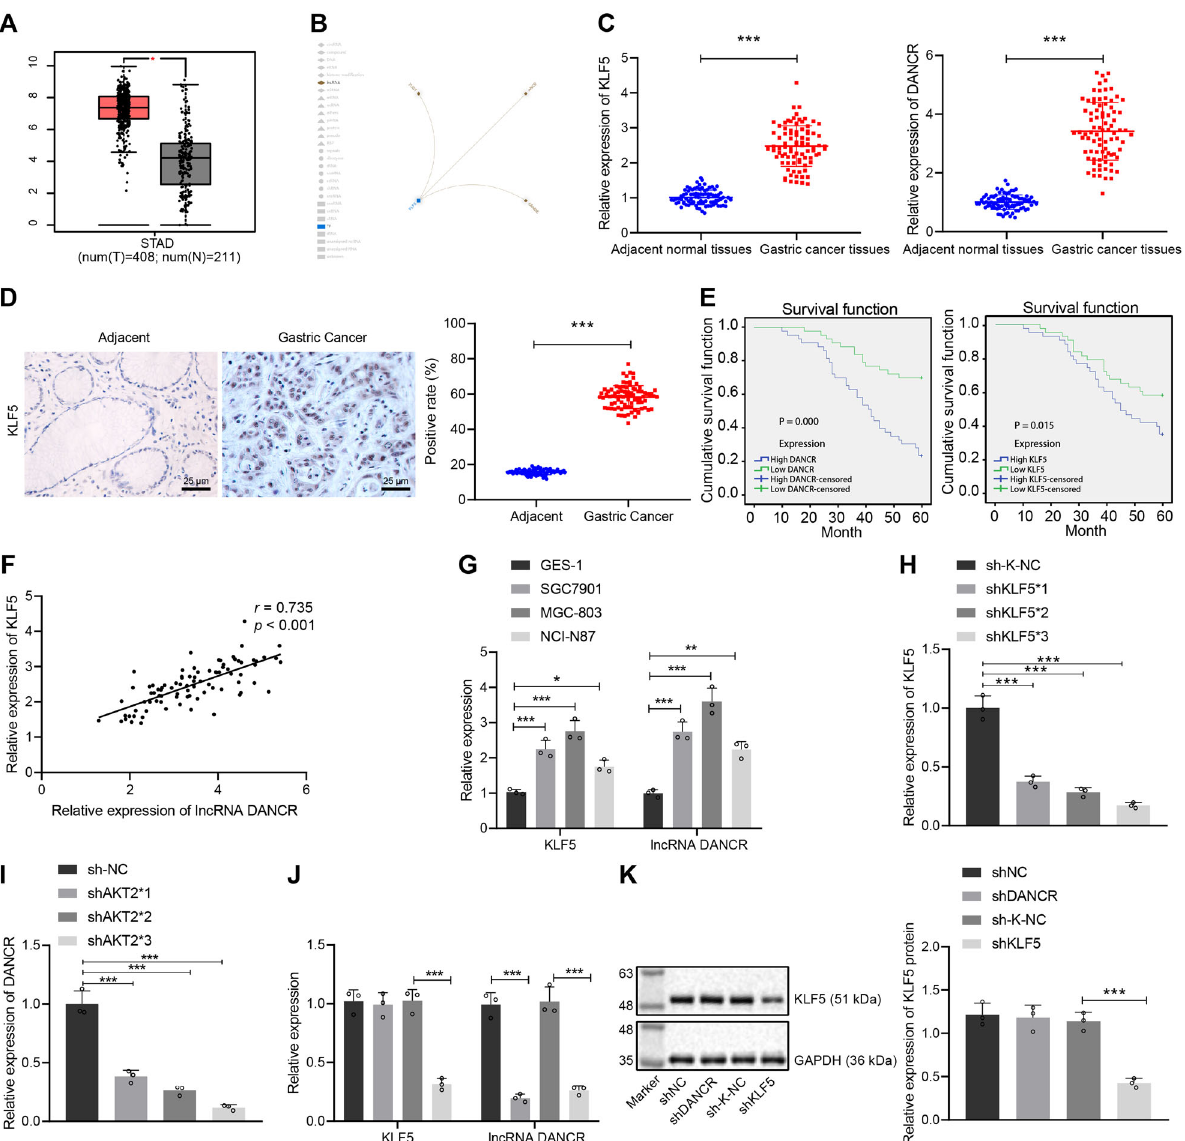
sample, and the ordinate represents the sample expression; B RNAInter analysis (http://www.rna-society.org/rnainter/) to predict the lncRNAs targeted by KLF5; C qRT-PCR to determine the expression of KLF5 and DANCR in GC tissues and adjacent normal tissues ( n = 86); D immunohistochemistry (400×) to detect the expression of KLF5 in GC tissues and adjacent normal tissues ( n = 86); E Kaplan – Meier method for survival analysis; F correlation analysis between KLF5 expression and DANCR expression; G qRT-PCR screening of cell lines with the highest expression of KLF5 and DANCR; H , I qRT-PCR to assess the silencing ef fi ciency of KLF5 and DANCR; J qRT-PCR measurement of KLF5 and DANCR expression in transfected cells of each group; K western blot analysis of KLF5 protein expression in transfected cells of each group. * p < 0.05, *** p < 0.0001. The measurement data are summarized by mean ± standard deviation. Data in A – D were analyzed by paired t test. Data in G – K were analyzed by one-way ANOVA with Tukey post hoc test. Pearson coef fi cient was employed to evaluate the correlation between KLF5 and DANCR. Kaplan – Meier method (log-rank test) was used for survival analysis in response to high or low expression of KLF5 and DANCR. Cellular experiment was repeated three